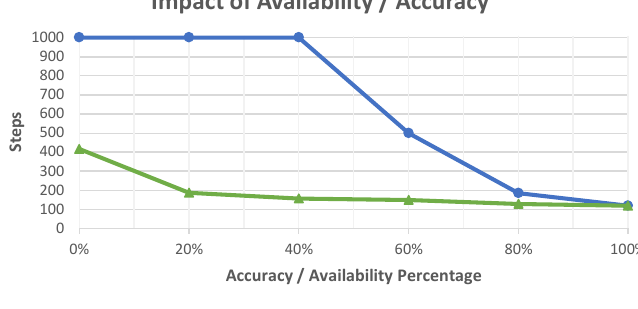
Figure 5. Evaluation of interactive reinforcement learning agents using simulated users with varying levels of availability and accuracy. Each characteristic is incremented by 20% for each experiment with the opposite characteristics set to the maximum. A total of 100 agents are run in each experiment and the steps needed to complete the task are recorded and averaged.